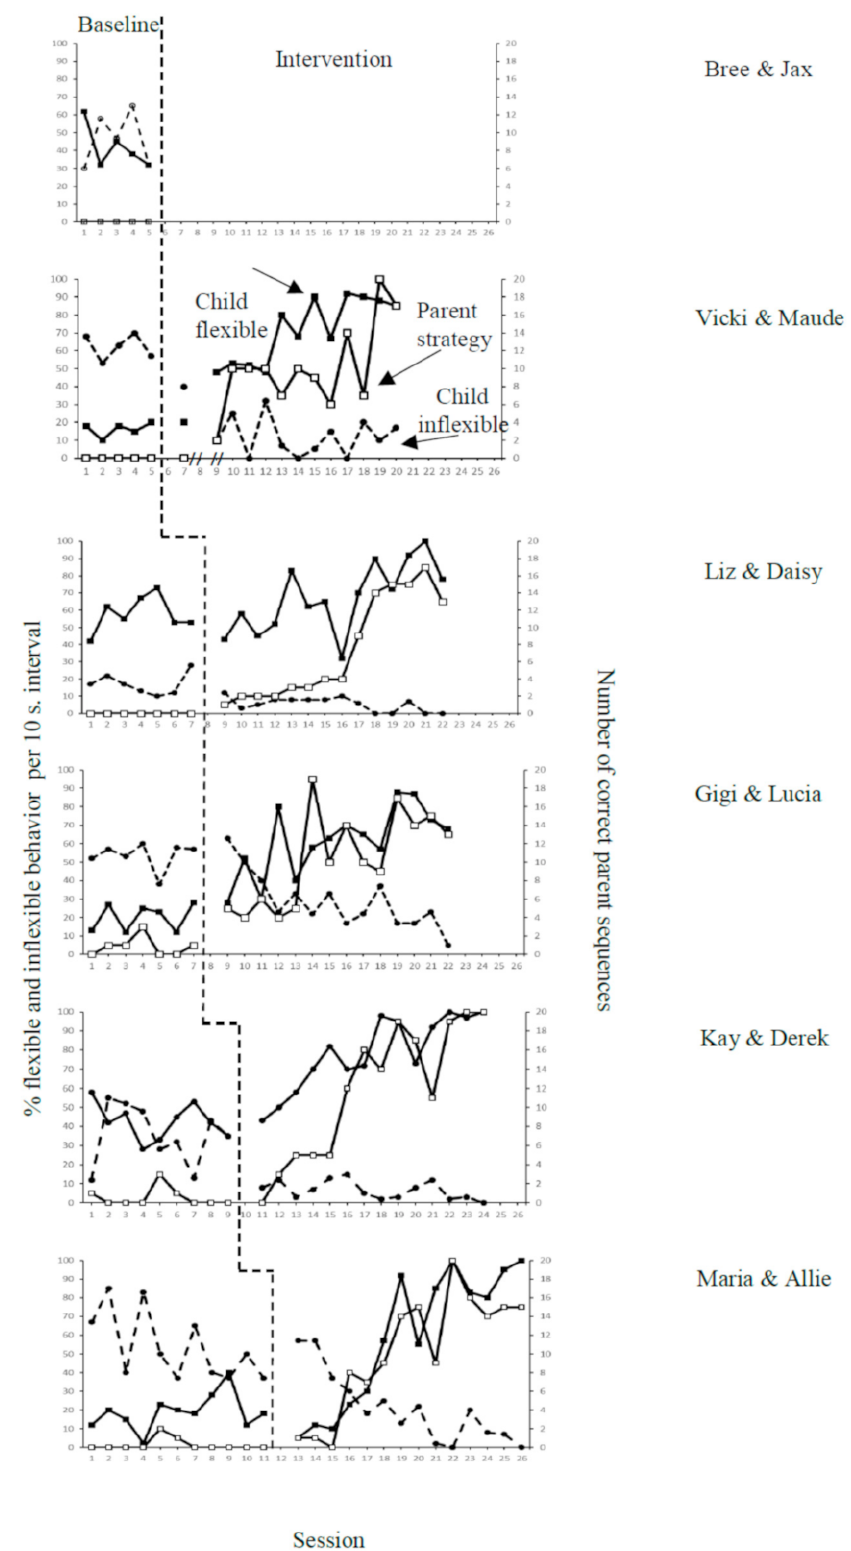
Figure 2. Parent strategy use, child flexible and inflexible